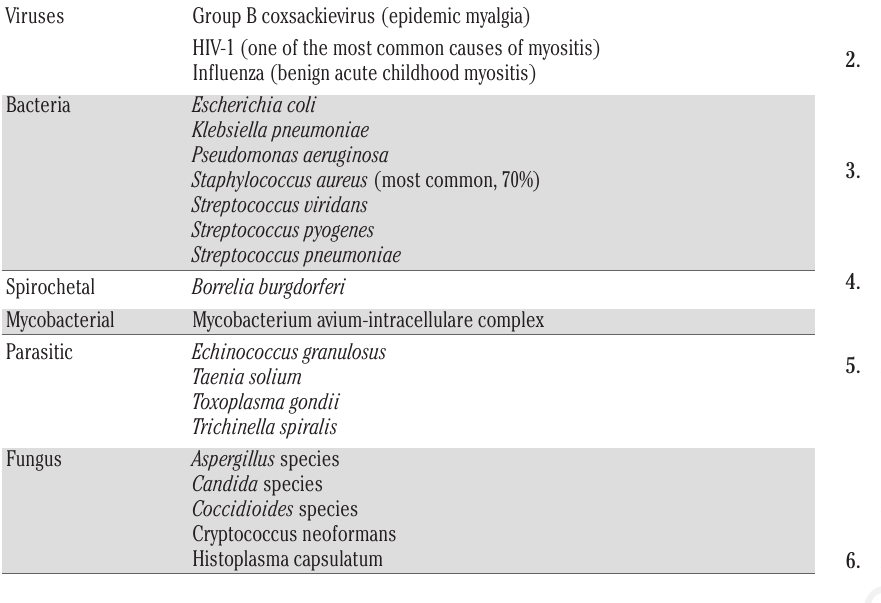
Table 1. Reported causes of infectious myositis. Viruses Group B coxsackievirus (epidemic